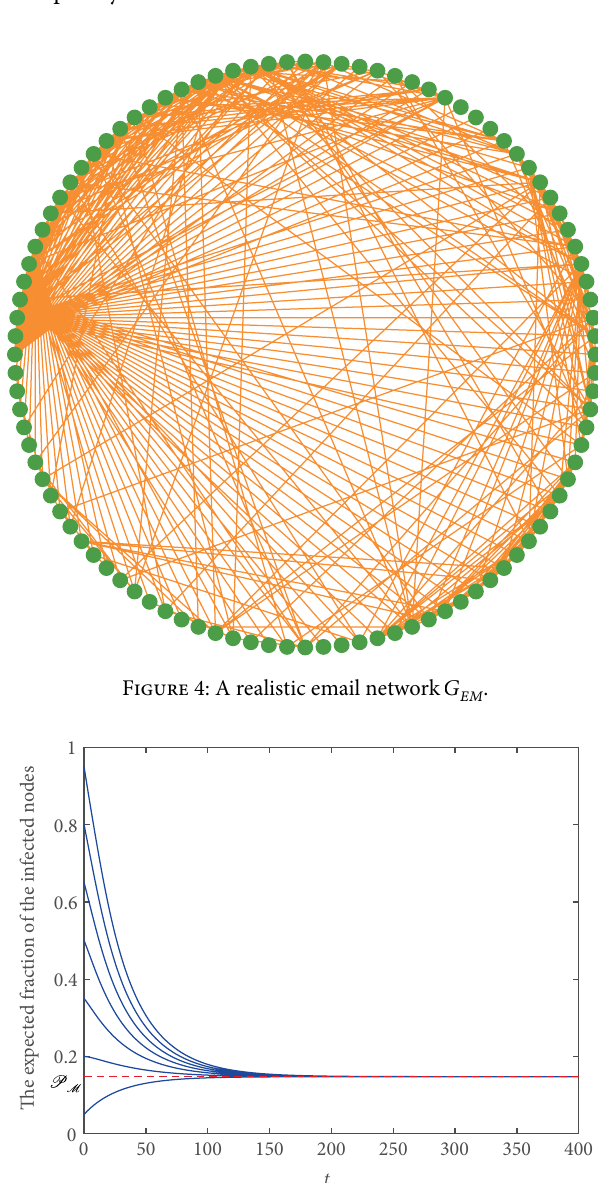
Figure7: The evolution of the expected fraction of the infected nodes in Example